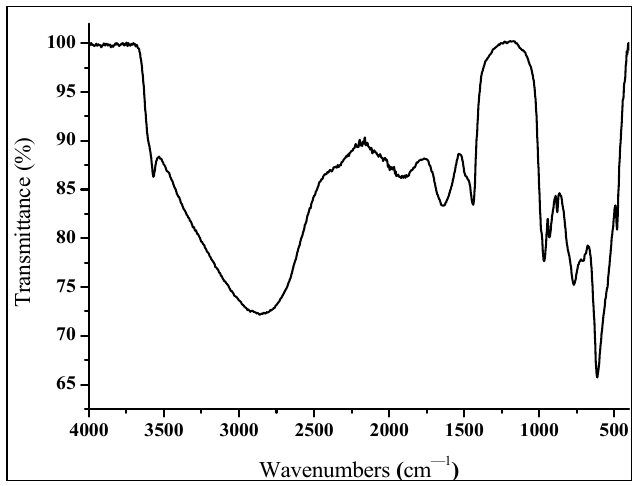
Figure 3. Sodium ferrate (VI)–Fourier transform-infrared